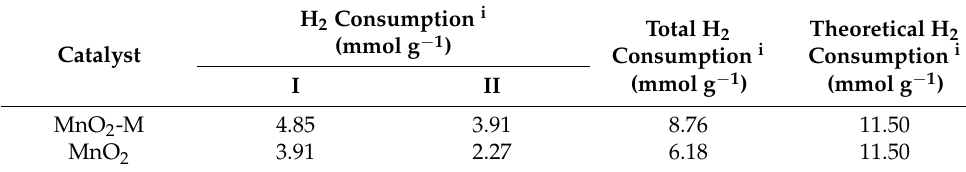
Figure 4. H 2 -TPR curves of the catalysts. Table 2. H 2 adsorption amount of the catalysts.